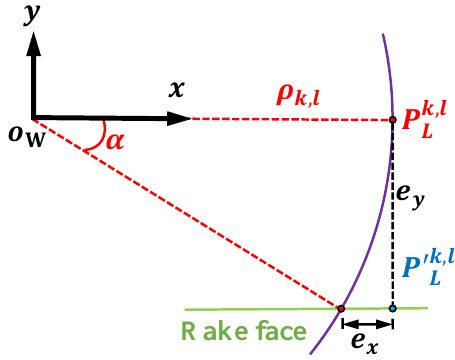
Figure 2. Schematic of the tool setting error